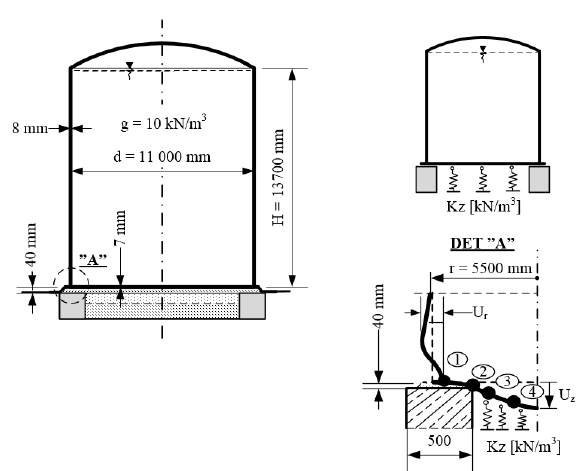
Figure 5: Geometry of the analyzed steel tank on a type B foundation and vertical deformations of the bottom plates u deformations u of the shell wall. r